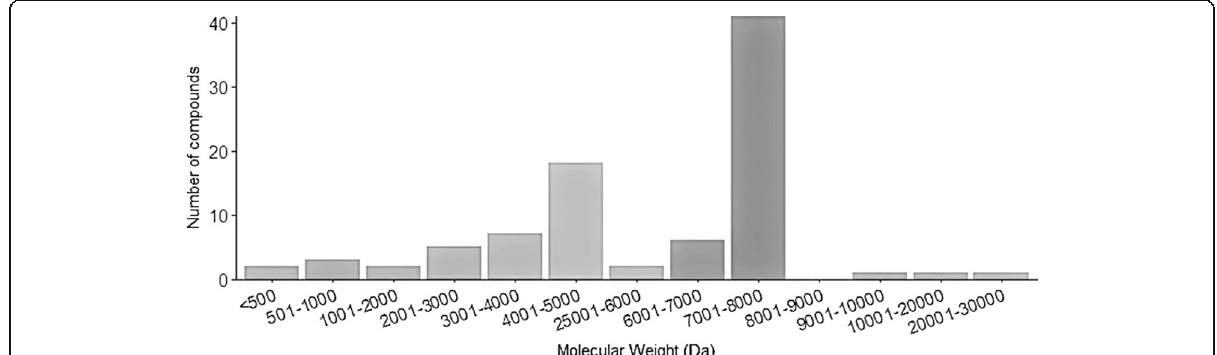
Fig. 2 Fingerprinting of soluble venom. The histogram shows the frequency distribution of molecular weights (MW), in Da, for the 89 peptide masses determined (from which 83 were distinct), present in the venom of Centruroides hirsutipalpus , clustered within different intervals of molecular weights (1000 Da apart from each other). The MWs were obtained using the mass spectrometer LCQ